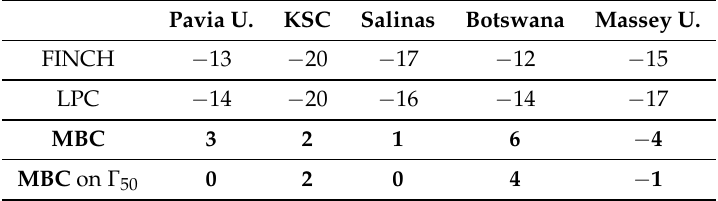
Table 7. Comparison of clustering results: Average difference between number of classes and number of discovered clusters. Negative values mean that too many clusters were discovered by the